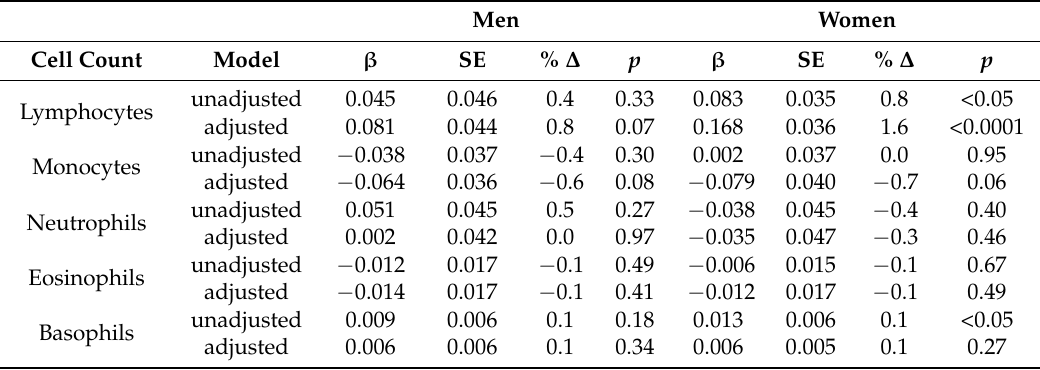
Table 4. Multiple regression models of serum total cholesterol levels predicting changes in peripheral blood leukocyte counts between men and women in NHANES 1999–2004.